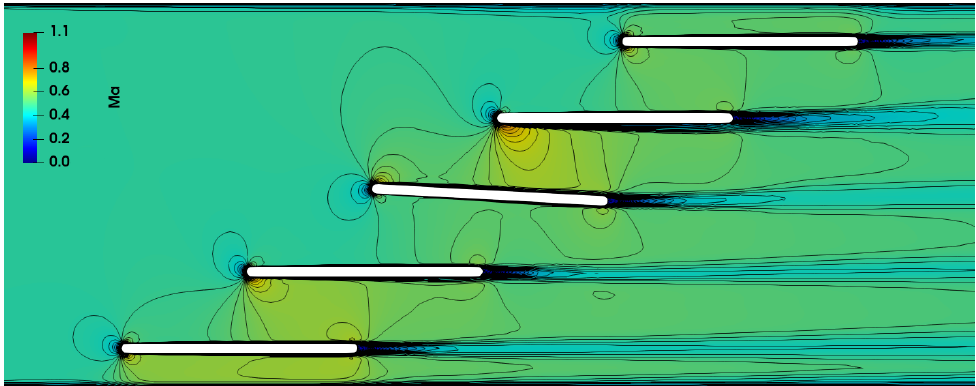
Figure 12. Distribution of the Mach number in the domain, M 2 is = 0.5, α =